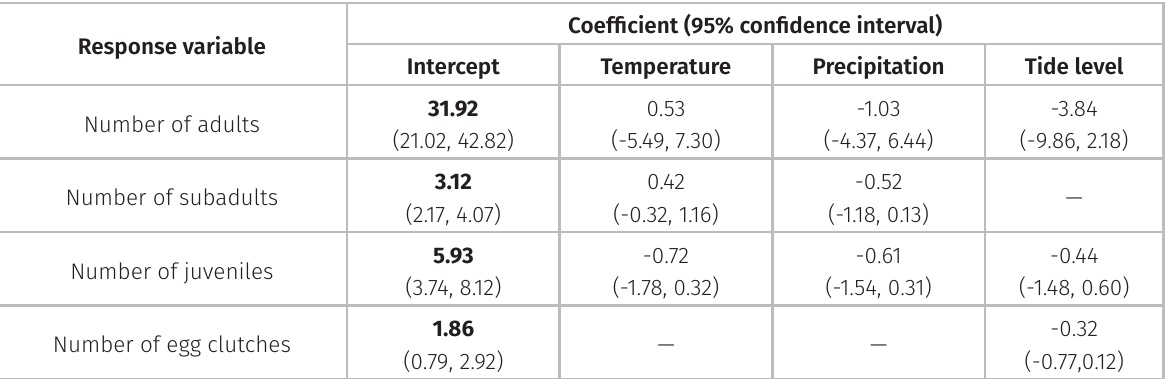
Table II. Coefficients of the predictor variables based on model average. The full list of models for each response variable is presented in Table I. When the 95% confidence interval does not cross zero, the coefficient is highlighted in